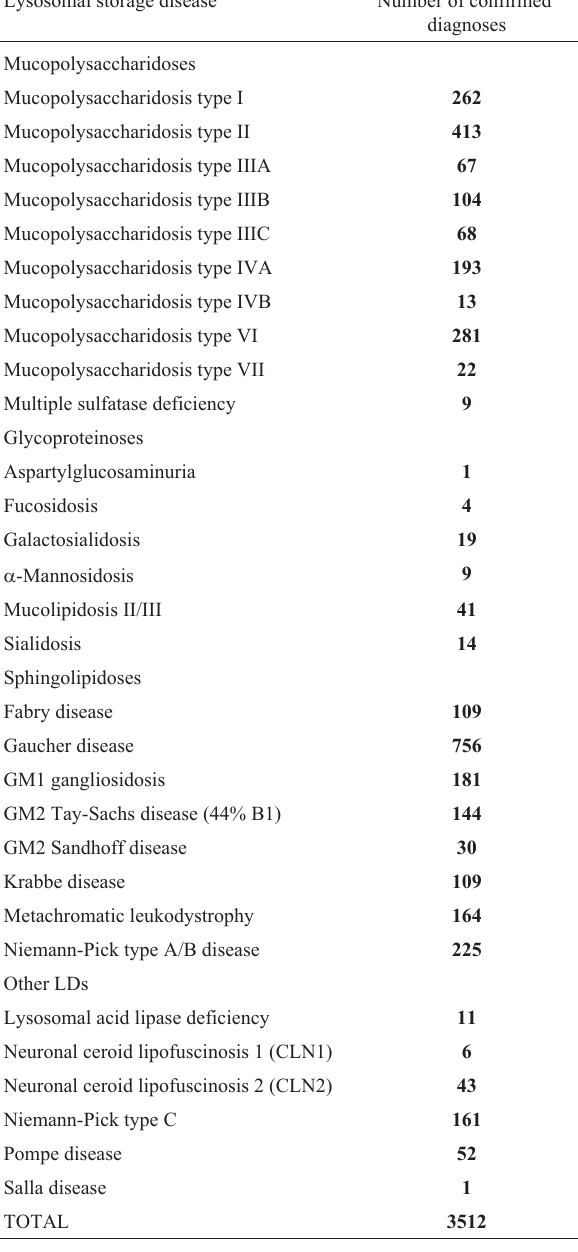
Table 1 - Lysosomal storage diseases diagnosed from 1982 to 2017 by the Reference Laboratory of Inborn Errors of Metabolism, Medical Genetics Service, Hospital de Clinicas de Porto Alegre,